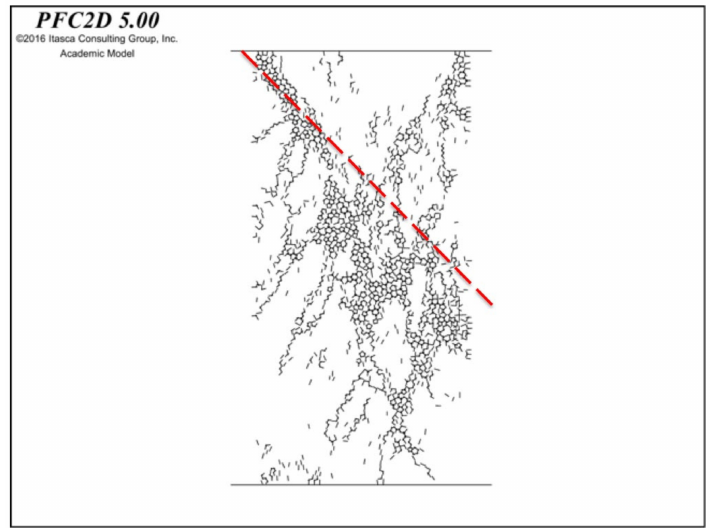
Figure 6. Localisation pattern in a 2D virtual sample; the load direction is vertical. The broken line indicates the predicted angle of 45 ◦ to the loading direction. Deviation of the localisation pattern from the 45 ◦ direction is caused by incremental anisotropy induced by the bond breakage that depends upon the direction of the applied compression.